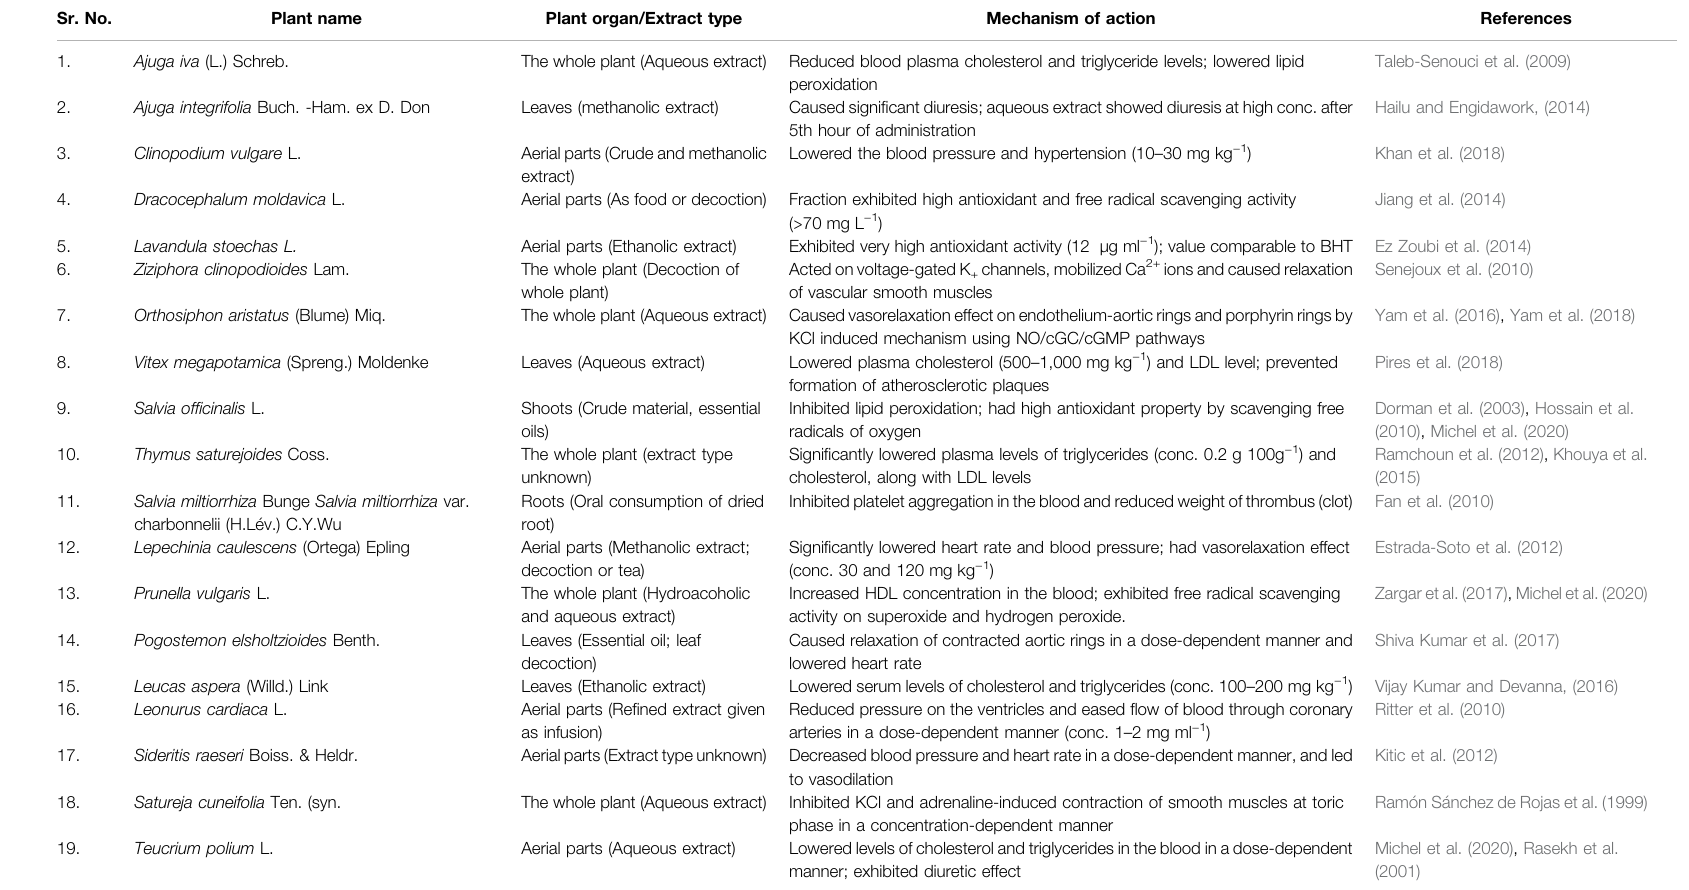
TABLE 1 | Mechanism of action of plants from Lamiaceae in the prevention of CVD. Sr.